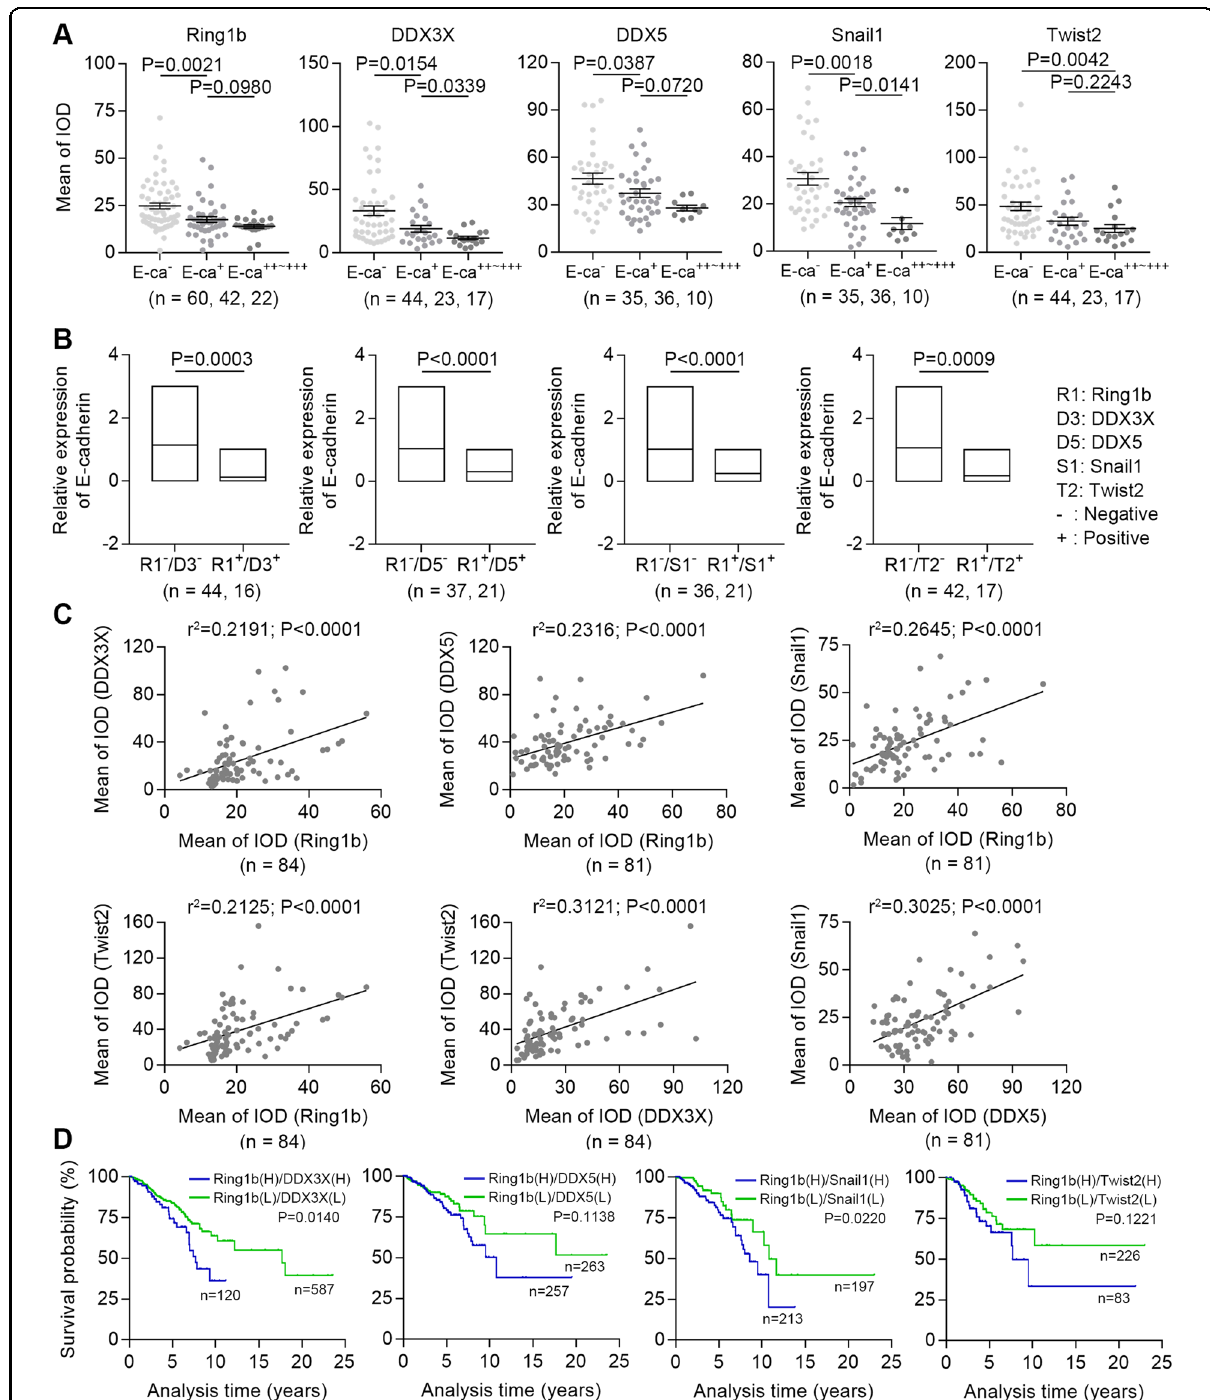
Fig. 8 Ring1b and associated proteins predict breast cancer metastasis. Mean integrated optical density (IOD) was used to evaluate expression of proteins in tissues. E-cadherin expression was determined by immunoreactive scoring system ( − negative, + weak, ++ to +++ moderate and strong, respectively). A Single factor analysis of E-cadherin expression in cancer tissues. B Double factor analysis of E-cadherin expression in cancer tissues. C Correlation analysis of Ring1b and associated proteins in cancer tissues. D Double factor analysis of survival curves in cancer tissues. The data from TCGA atlas were analyzed by Kaplan – Meier method. Paired t -test is performed to indicate a statistically signi fi cant